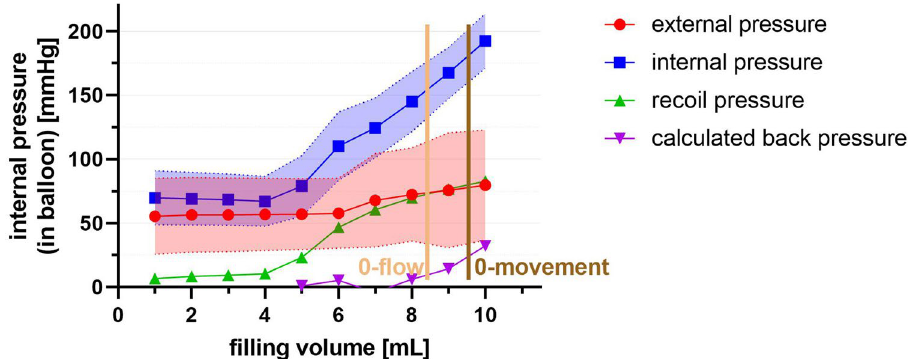
Figure 5. Measured pressures (external, internal, recoil) and calculated back pressure from the vessel wall. Once the balloon is inflated to 21 mm (inner diameter of the tube) at 8 mL filling volume, pressure in the balloon rises without any changes to the surrounding blood pressure, and flow stops (0-flow). Adding 1 mL filling volume increases the pressure enough so that the balloon is wedged in the vessel wall and any pulsatile movement stops (0-movement). Further balloon filling exerts pressure on the vessel wall only, without changes to blood